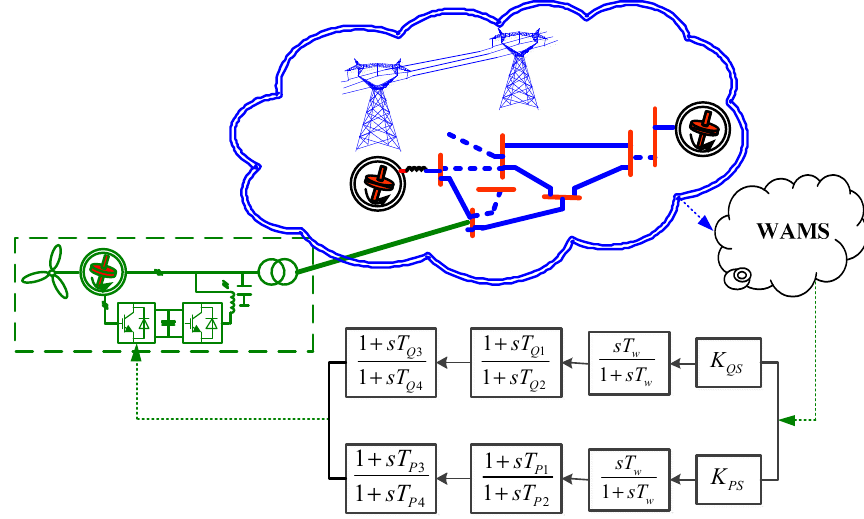
Figure 4. Block diagram of the dual-channel additional damping controller.